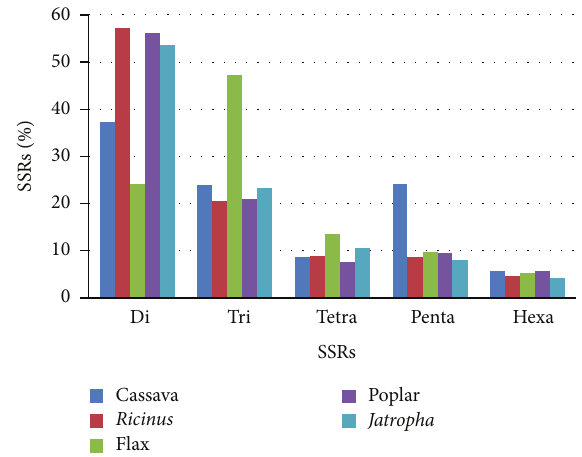
Figure 2: Frequency (%) of the number of each motif of identified SSRs in the assessed species.